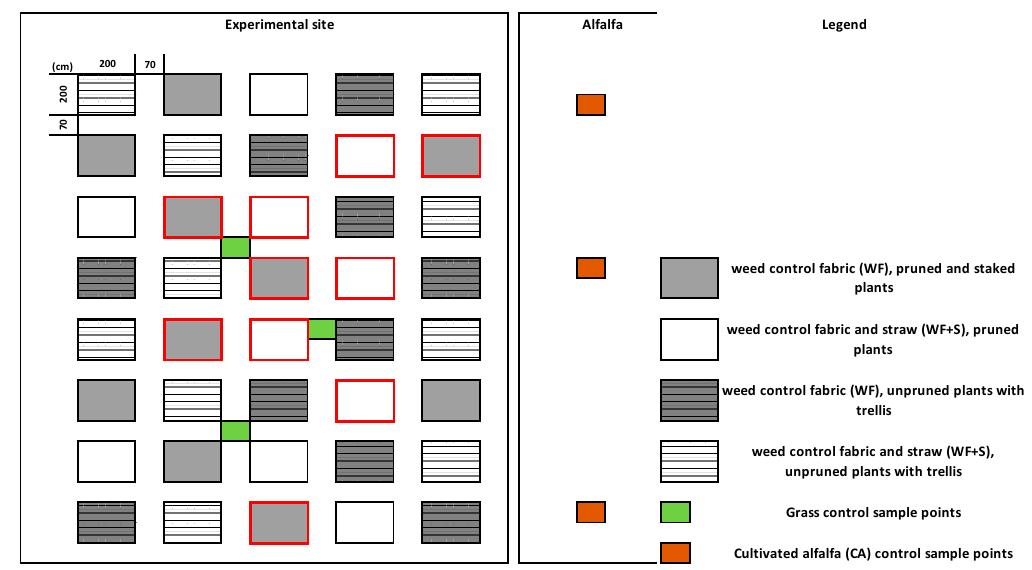
Figure 2. Experimental setup, the arrangement of microplots and sample points ( ˝Osag á rd, Hungary, 2018–2021). Microplots with red borders were sampled for soil parameters and for